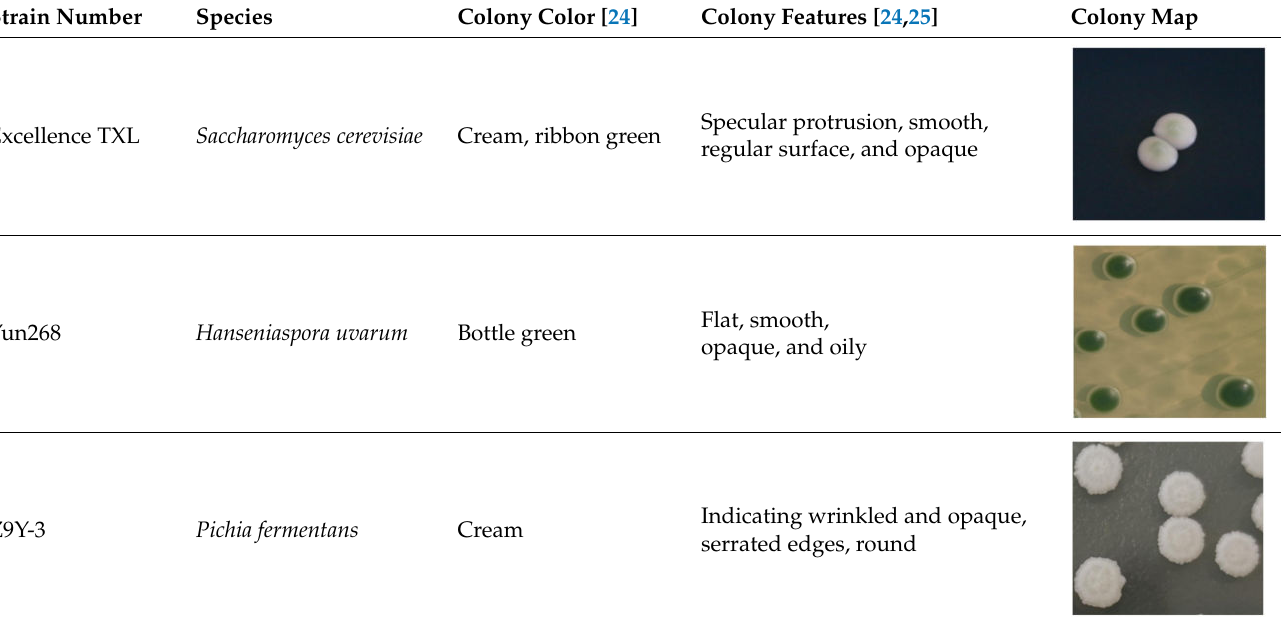
Table 1. Colony morphology of